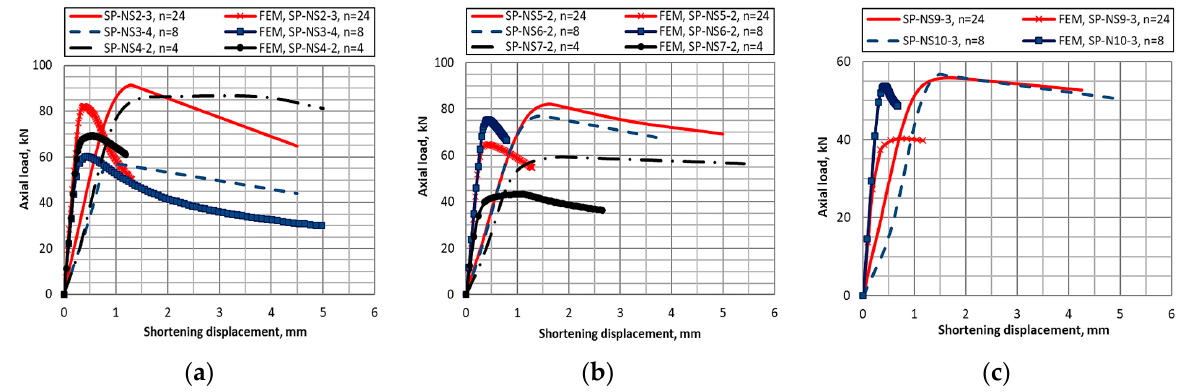
Figure 12. Experimental and numerical results for DoO = 16.80% ( a ), DoO = 28.30% ( b ) and DoO = 42.90% ( c ).